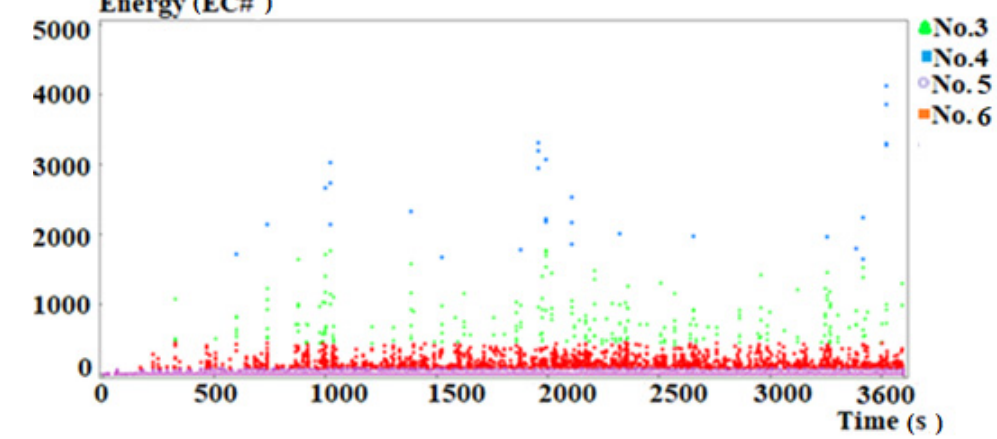
Figure 19. Energy versus time for the first measurement period—March 2016.